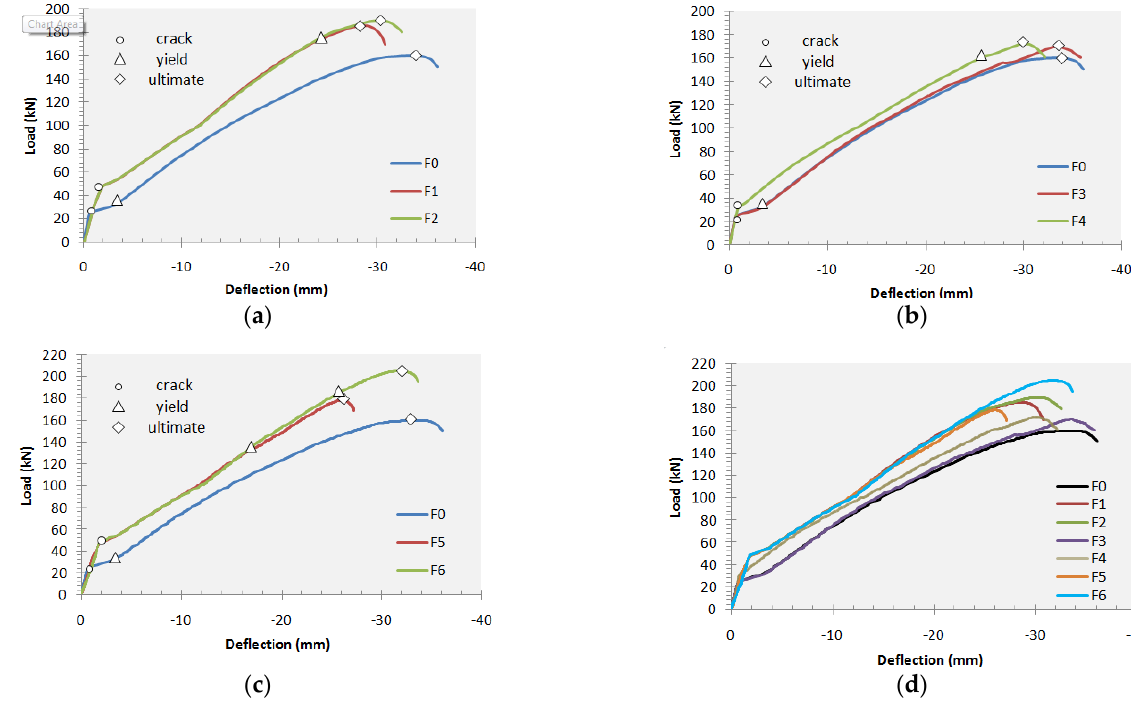
Figure 17. Load–deflection curves for F 0 , F 1 , F 2 , F 3 , F 4 , F 5 and F 6 : ( a ) straight–line tendons at the positive bending zones of the frame–beam (F 0 with F 1 , F 2 ); ( b ) straight–line tendons at the negative bending zones of the frame (F 0 with F 3 , F 4 ); ( c ) straight–line and U–shape line tendons along the frame–beam (F 0 with F 5 , F 6 ); ( d ) all tendon techniques versus the original frame (F 0 with F 1 , F 2 , F 3 , F 4 , F 5 , F 6